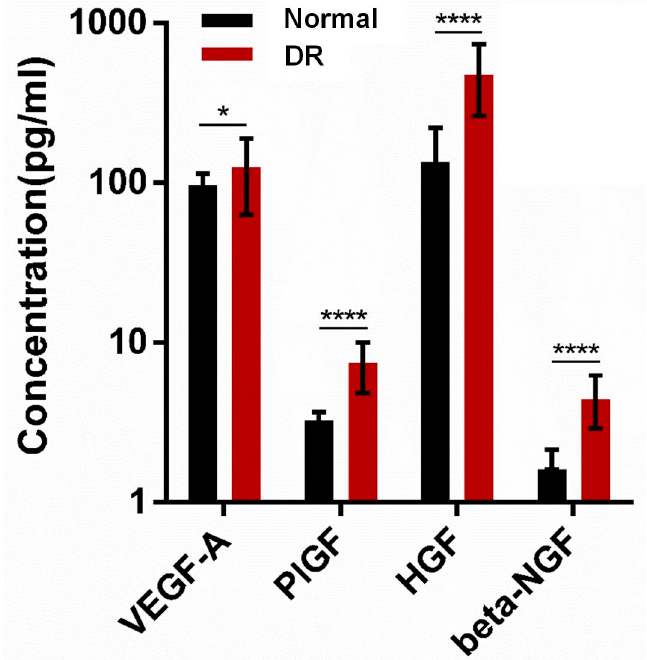
Figure 3. Growth factors levels between the normal and DR groups. The data were compared using Student’s t -test and differences were considered significant when, * for p < 0.05, **** for p < 0.0001. Spearman correlation between height, weight, WC, BMI, and adipokines was per- formed in all patients. Furthermore, Spearman correlation between adipokines and DM duration was performed. Adiponectin, leptin, resistin, TNF- α , Factor D (adipsin), CCL2 (MCP-1), lipocalin-2 (NGAL), Serpin E1 (PAI-1), IL-1 β , and CXCL8 (IL-8) were significantly positive correlated with WC (Figure 4). Each of them had a positive correlation with WC (Spearman r = 0.3557, 0.2653, 0.1719, 0.2287, 0.3632, 0.2144, 0.4262, 0.2698, 0.2145, and 0.2514, respectively). In sub-group analysis of DR, adiponectin, leptin, resistin, TNF- α , Factor D (adipsin), CCL2 (MCP-1), lipocalin-2(NGAL), Serpin E1 (PAI-1), IL-1 β , and CXCL8